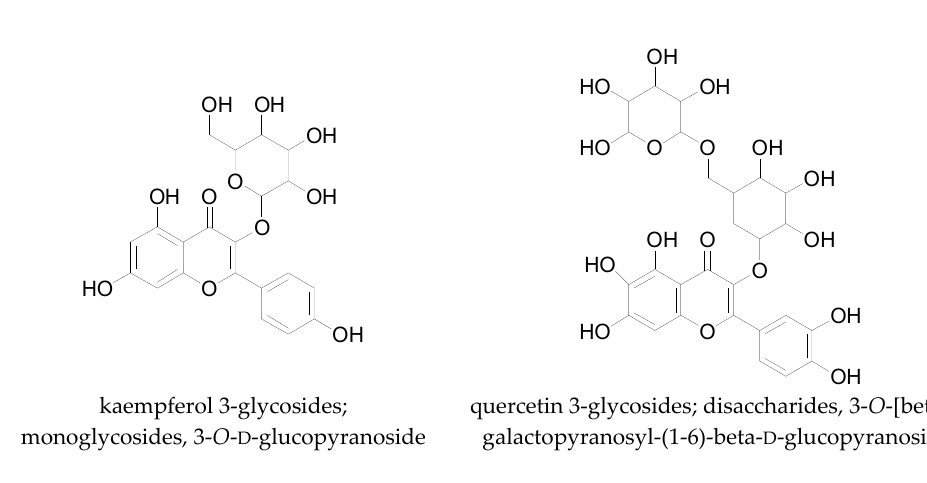
Figure 12. Chemical structures of some flavonoids in cotton.